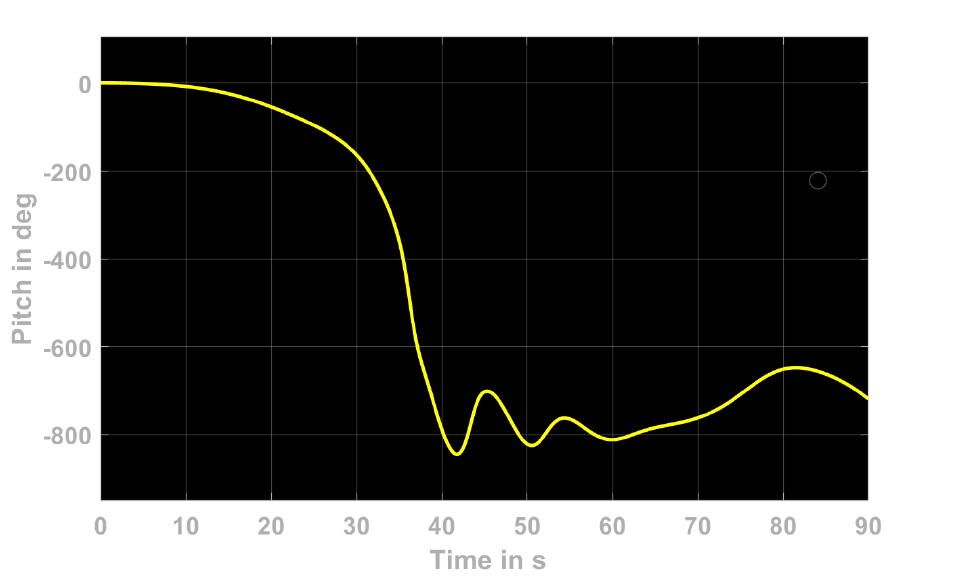
Figure 12. Dynamics in the vertical plane predicted by the LPM for the baseline: pitch output of the craft vs. time.